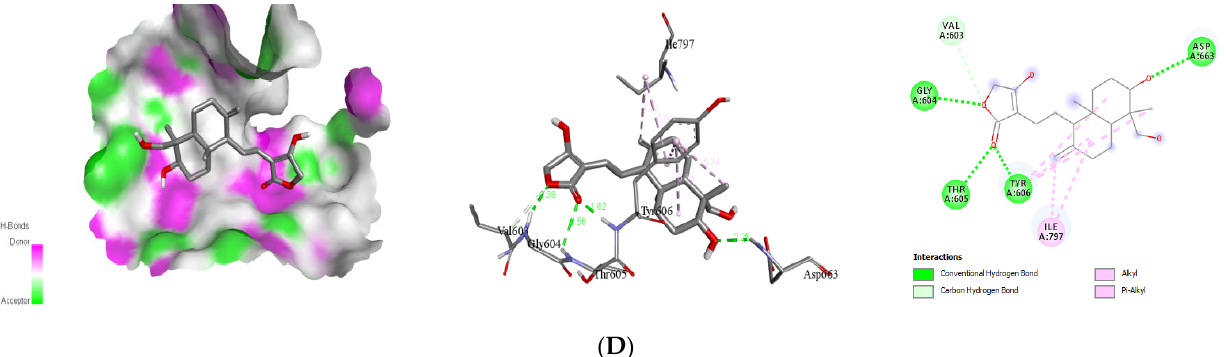
Figure 5. Binding poses of four top-ranked compounds at the binding site of dengue virus NS5 (PDB ID: 4V0Q) and 2D and 3D interaction diagrams. ( A ) Triptolide-NS5; ( B ) stevioside-NS5; ( C ) caesalacetal-NS5; ( D ) andrographolide-NS5. Table 4. The four best results for the docking of natural bioactive ligands with viral NS5 proteins